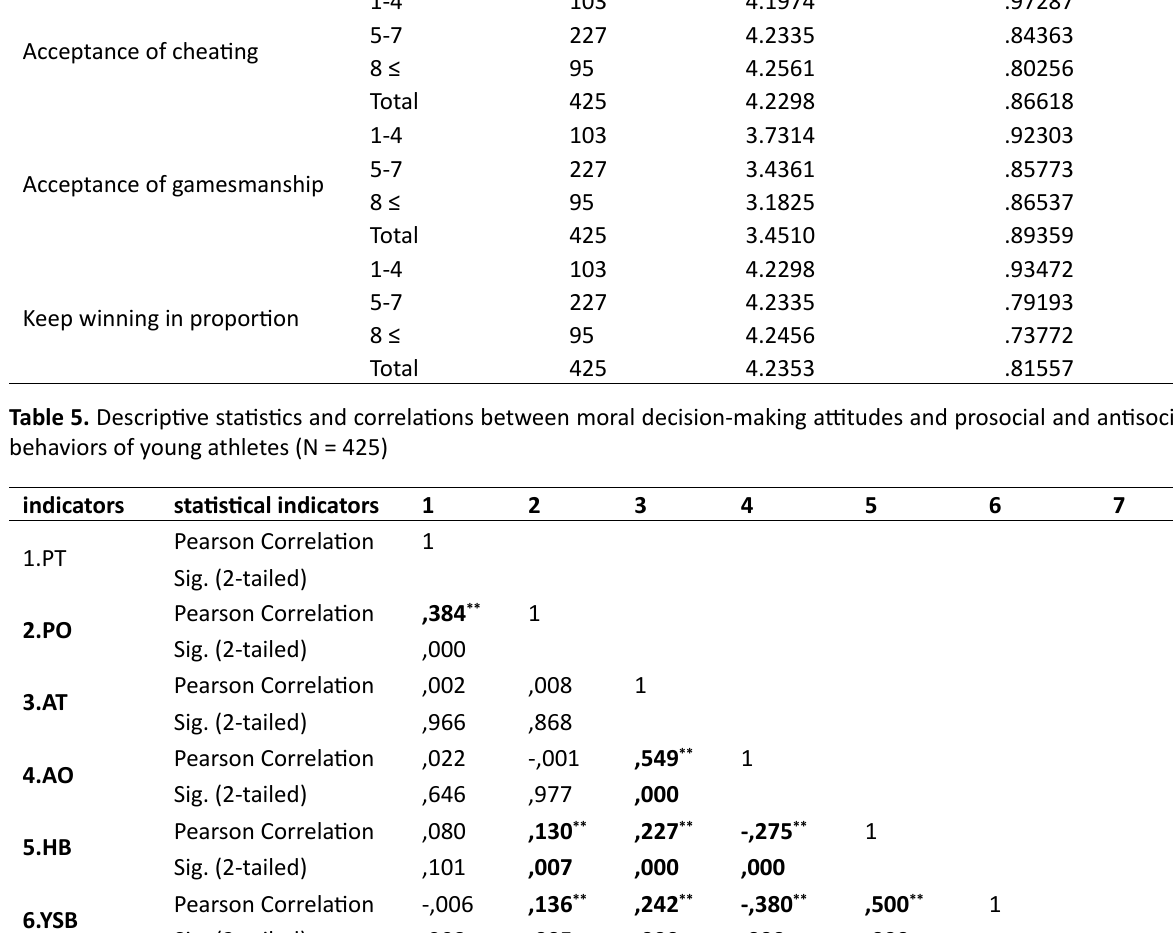
Table 4. An analysis of the variance of moral decision-making attitudes of athletes according to the sport year Scale